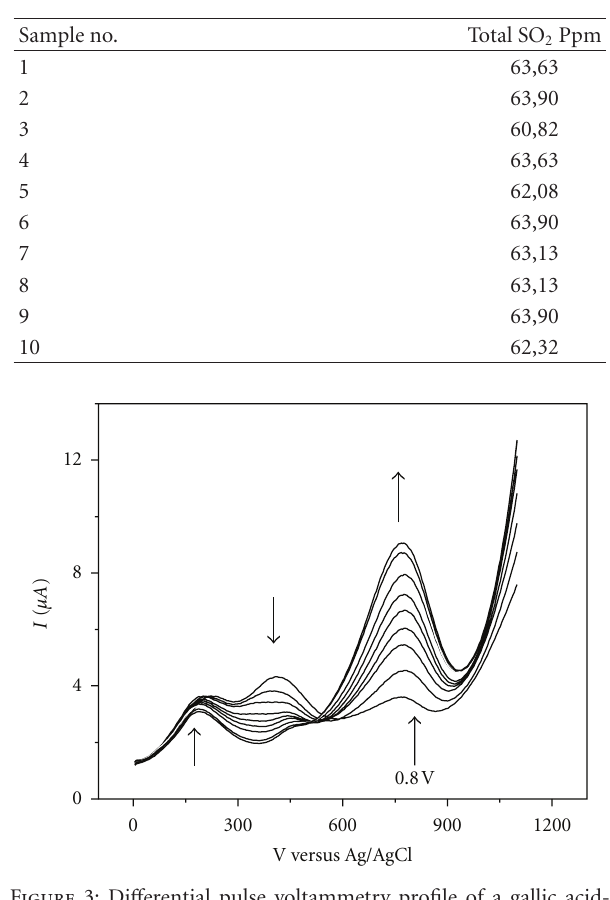
Figure 3: Di ff erential pulse voltammetry profile of a gallic acid- sulfite mixture using standard addition method (ten 2-mL sulfite solution additions). Sulfite and gallic acid initial concentration 2mM and 1mM, respectively.